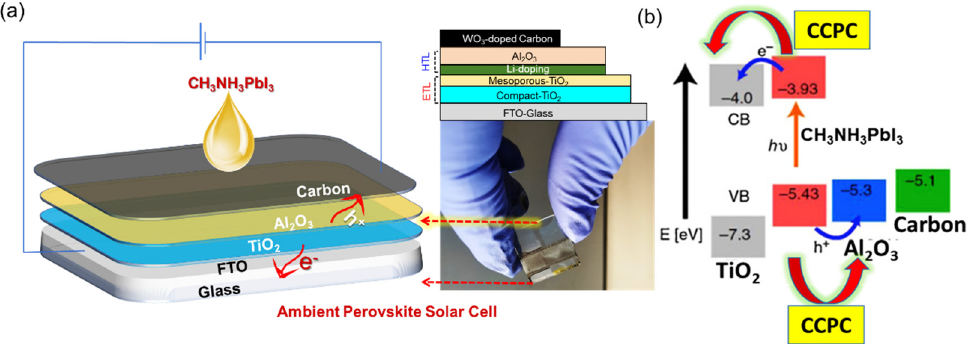
Figure 1. The ( a ) schematic representation of the ambient PSC device architecture, with TiO 2 as the electron transporting layers (ETL), Al 2 O 3 as a hole transporting layer (HTL), WO 3 added carbon back electrode, Li-doping facilitated electron-hole separation, and CH 3 NH 3 PbI 3 injected on top of the carbon layer, with a photograph of a fabricated PSC device, and ( b ) an energy level diagram of the different layers of the PSC.